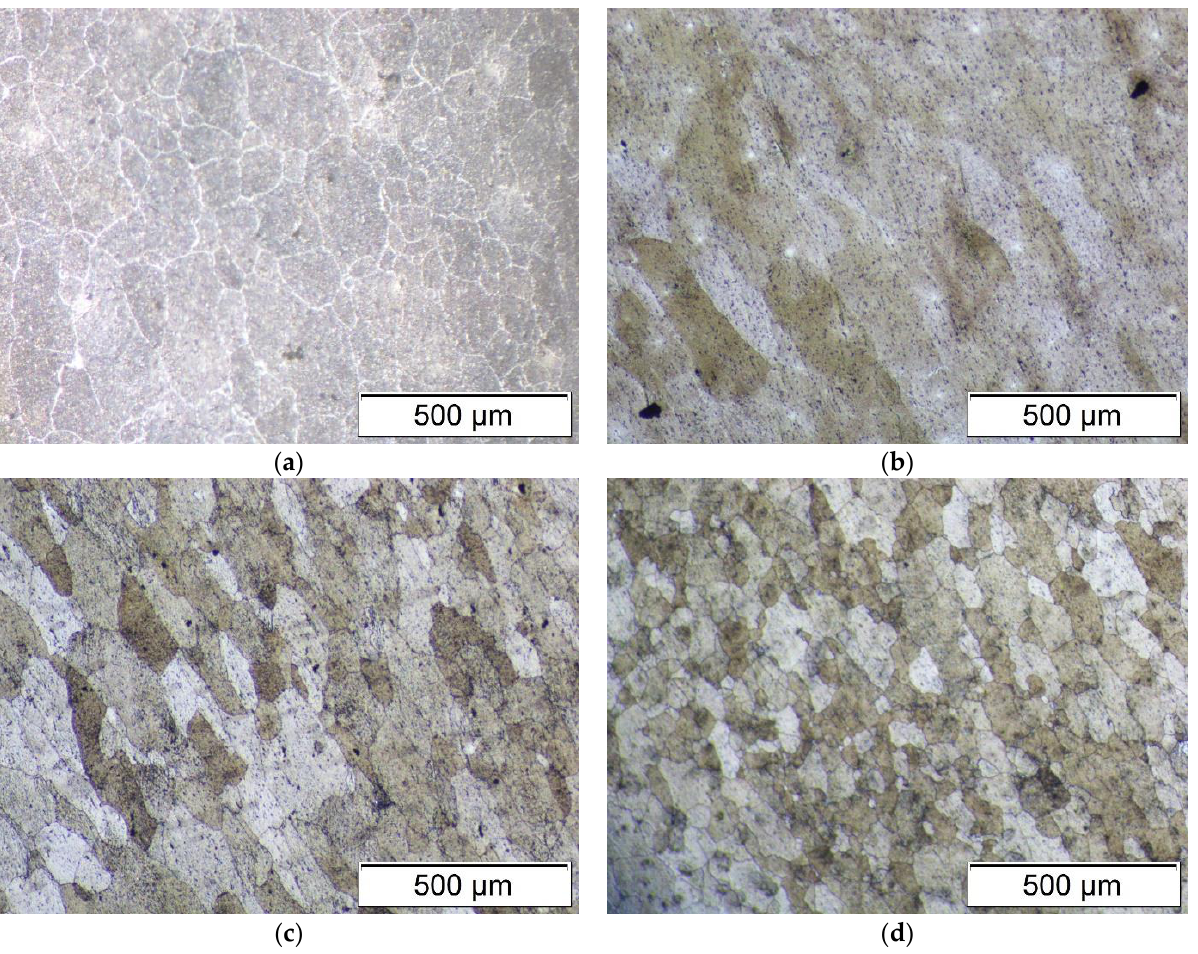
Figure 9. OM micrographs of AA2011 for ( a ) AA, ( b ) 1- p , ( c ) 2-Bc, and ( d ) 4-Bc at 150 °C.